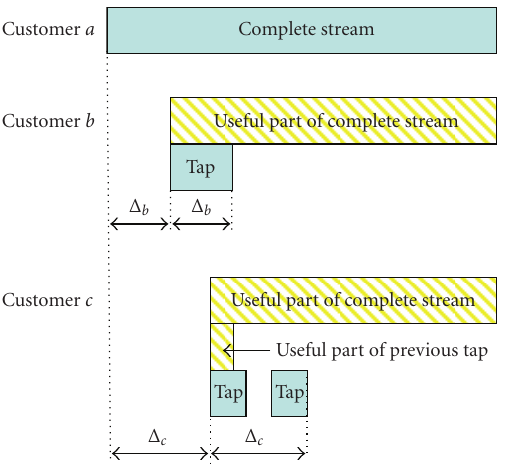
Figure 2: How stream tapping